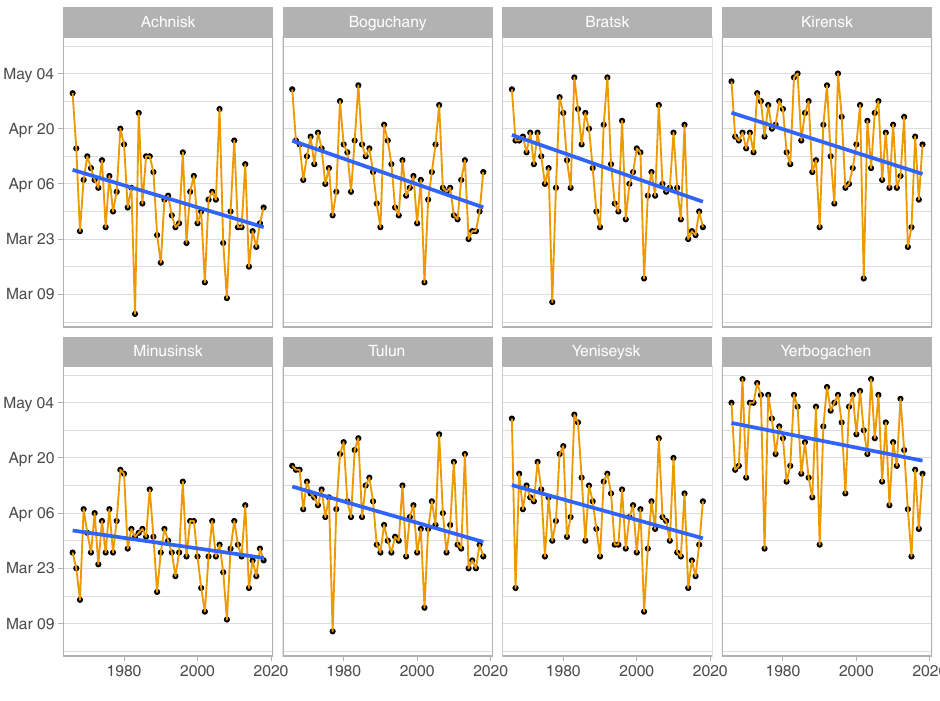
Figure 6. Annual shifts of season end